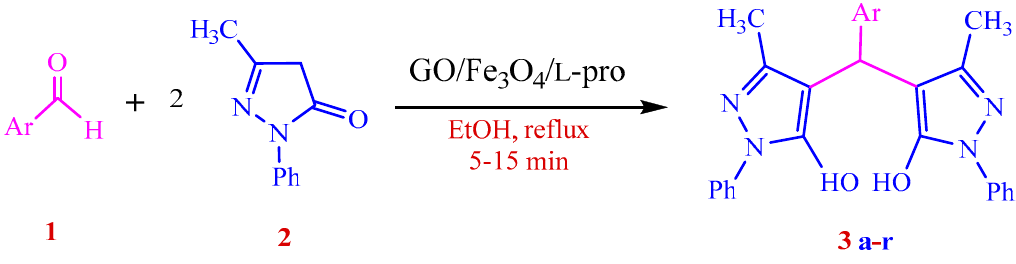
Table 2. Synthesis of bis-pyrazole derivatives ( 3a – r ) catalyzed by GO/Fe 3 O 4 / L -proline.